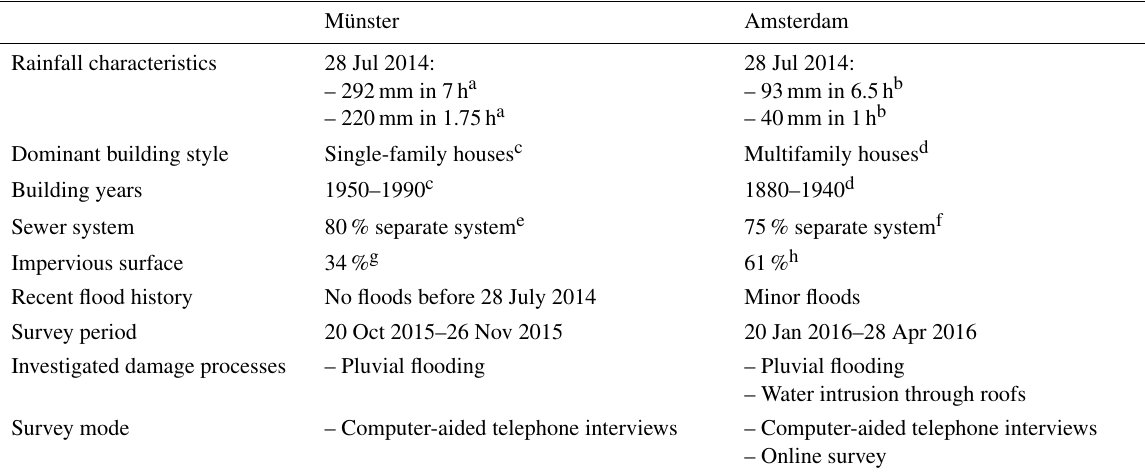
Table 1. Key features of the two case studies.